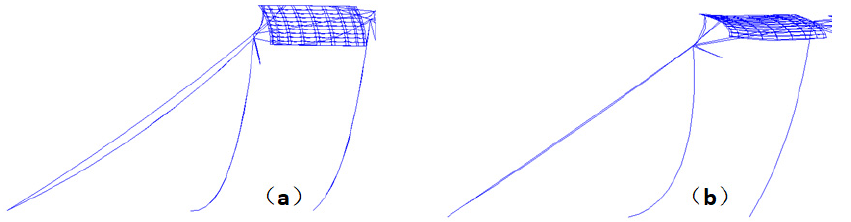
Figure 7. Deformation of upstream mooring cables: ( a ) under current velocity of 0.25 m/s, ( b ) under current velocity of 1 m/s).